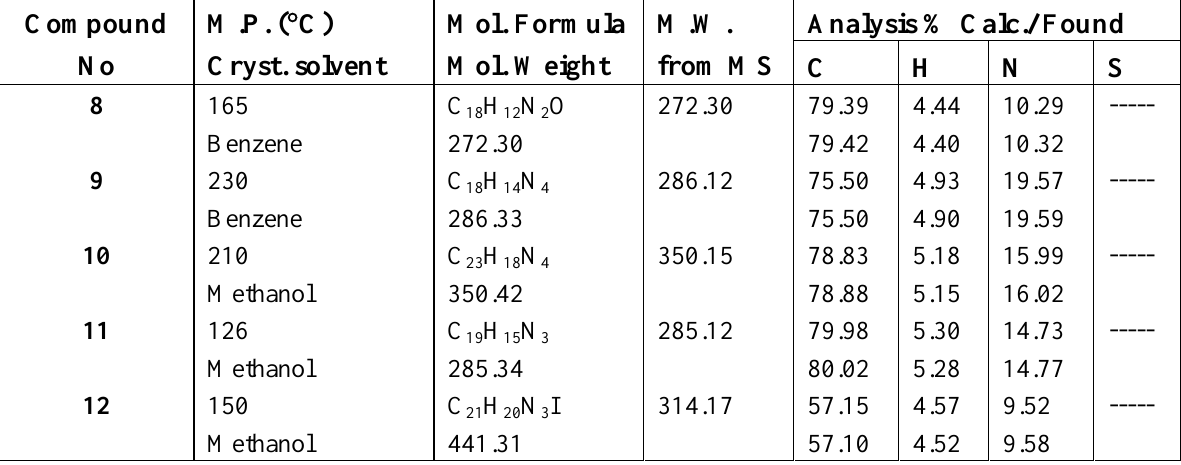
The reaction of pyridazinone 3a with benzene/4-toluenesulfonyl chloride and anhydrous K